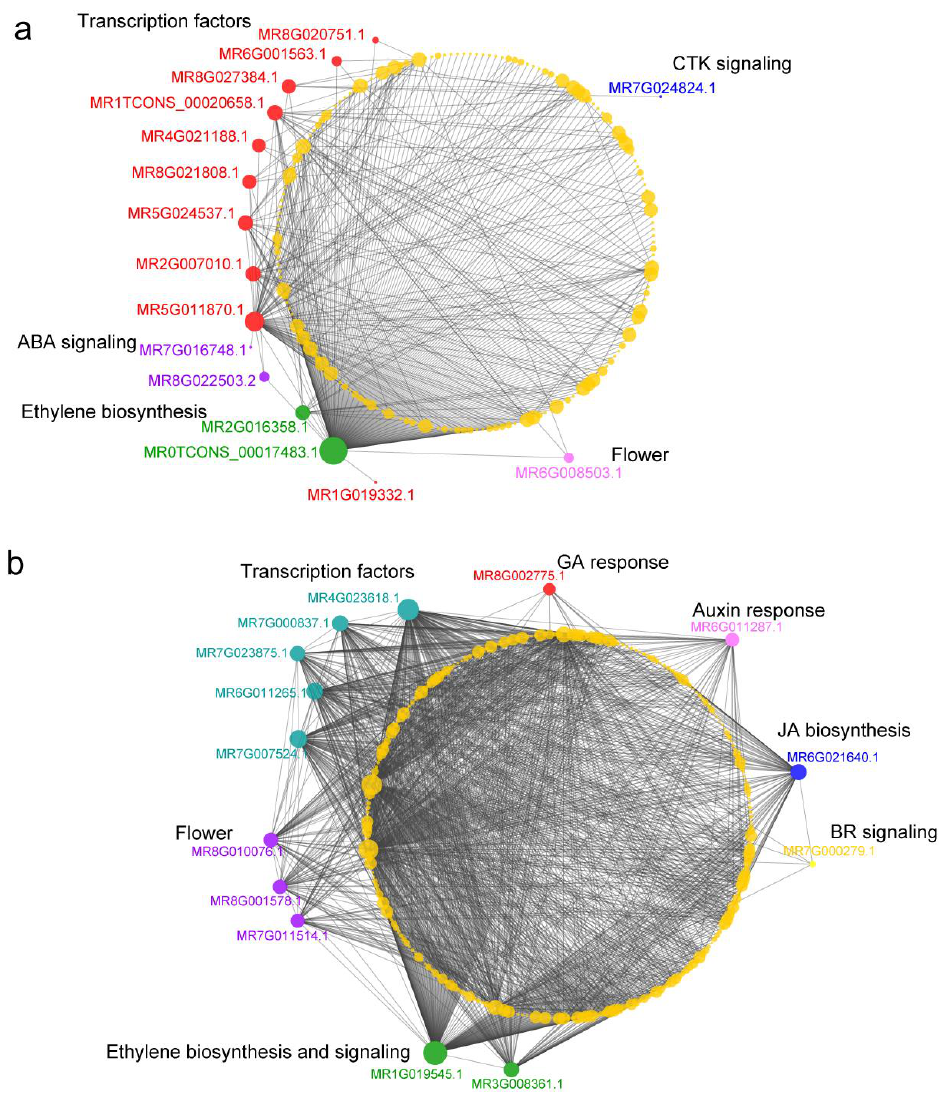
Figure 6. Visualization of co-expression network. ( a ) Co-expression network of genes in light-green modules. ( b ) Co-expression network of genes in dark-cyan modules.